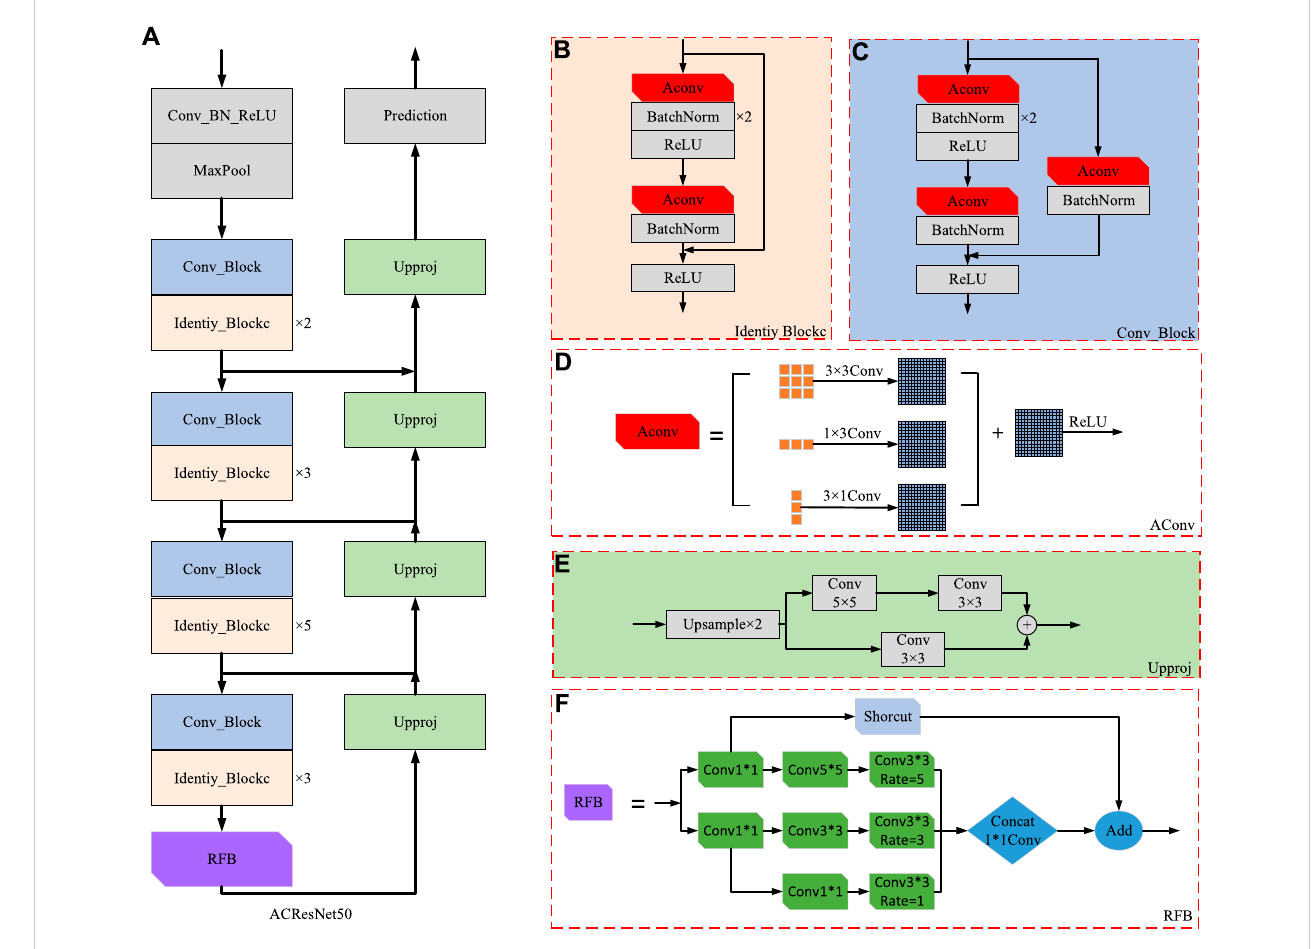
FIGURE 2 Depth estimation network model: (A) ACResNet50 structure; (B) Identiy_Block structure; (C) Conv_Block structure; (D) AConv structure; (E) Upproj structure; (F) RFB